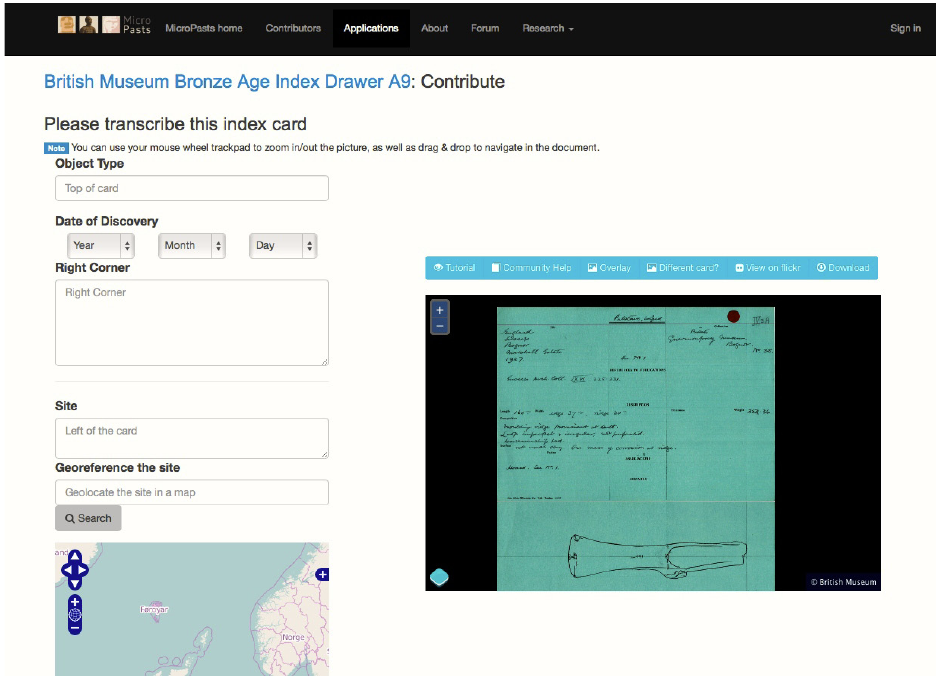
Fig. 2: Interface of one of the MicroPasts transcription applications.